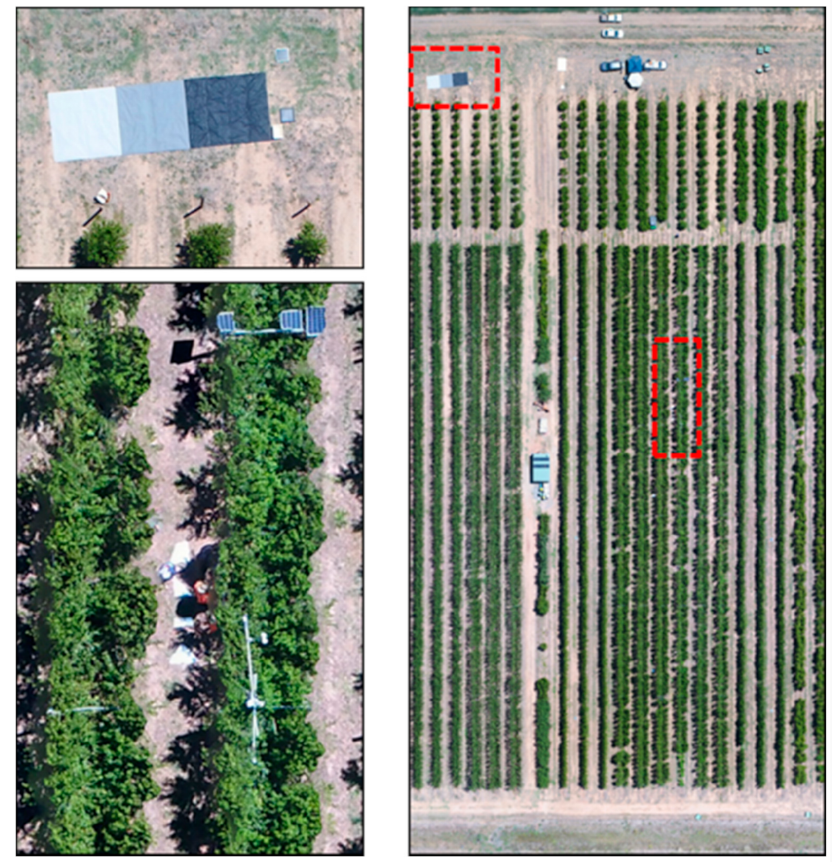
Figure 2. Field description: ( top left ) radiometric grey targets and temperature targets; ( bottom left ) the details of sampling trees and meteorological tower; ( right ) the locations of targets and sample trees are enclosed in red